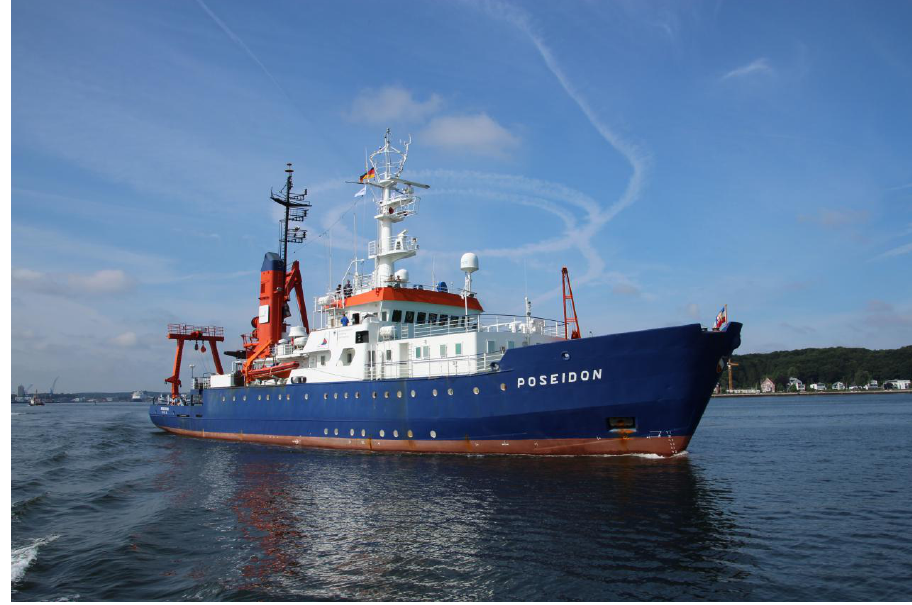
Figure 1: R/V Poseidon in the Kiel